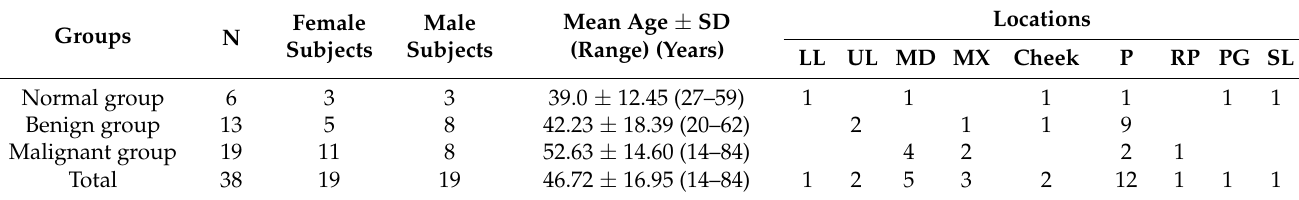
Table 1. The demographic characteristics of the study population.